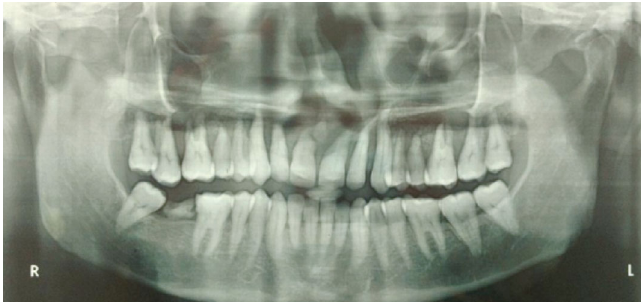
Figure 3: Panoramic radiograph of the patient revealing evidence of interdental bone loss in relation to all the maxillary teeth.